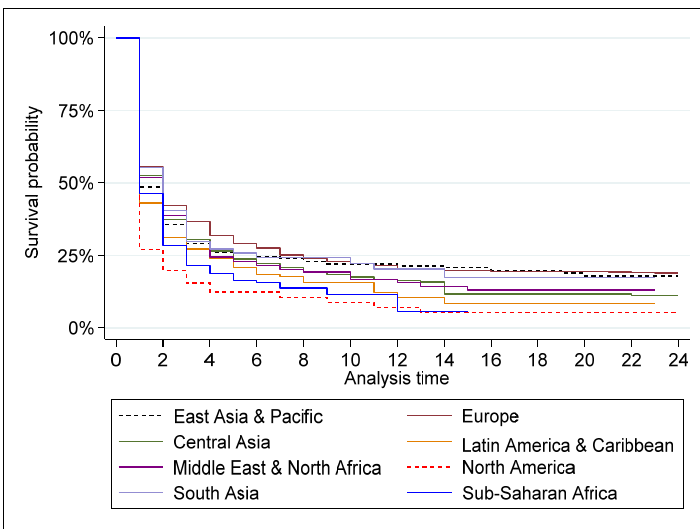
Figure 7. Kaplan–Meier survival estimate for Russian non-renewable energy exports by geographical region. Source: Authors’ elaboration based on data retrieved from CEPII database.